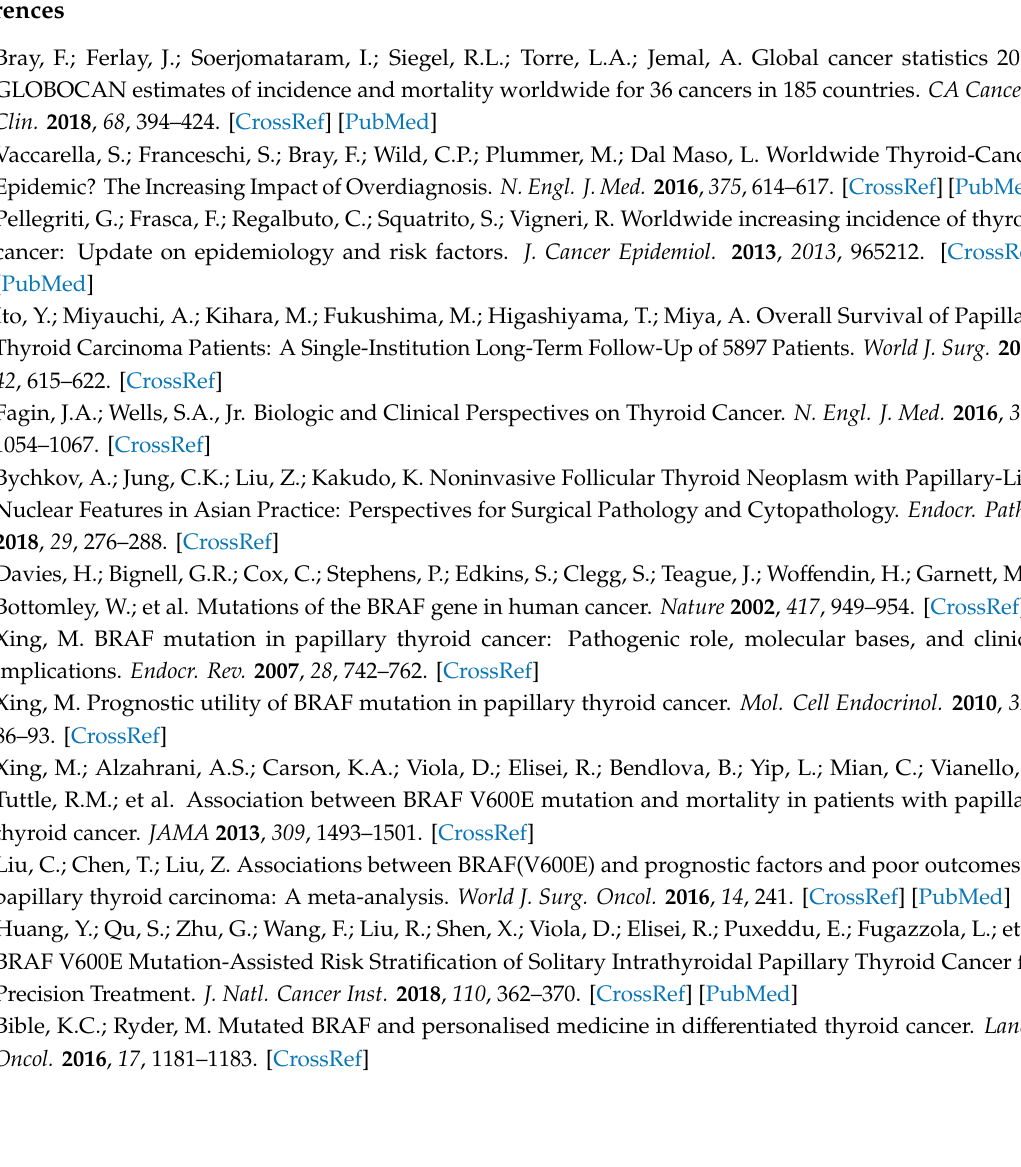
Table S1. Correlation between BRAF V600E and clinicopathological parameters in 514 patients with papillary thyroid carcinoma, Table S2. Clinicopathological features of three patients with false negative VE1